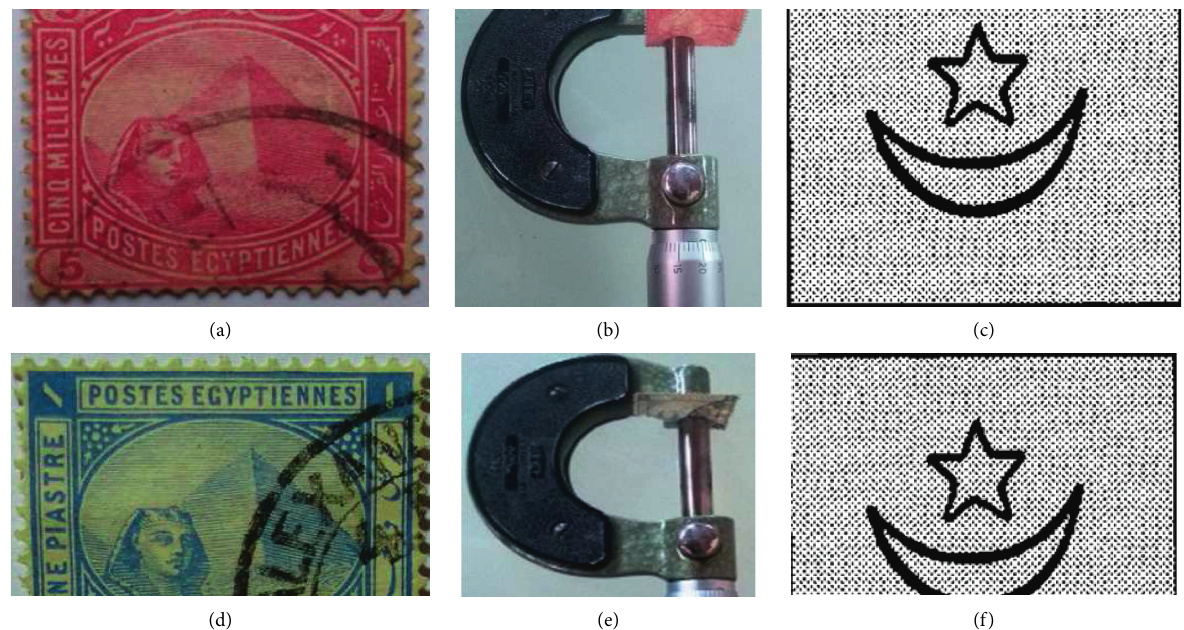
Figure 1: The stamp form. Red color and shape (a), blue color and shape (d), measurement of the stamp thickness (b, e), and the stamp watermark (c,